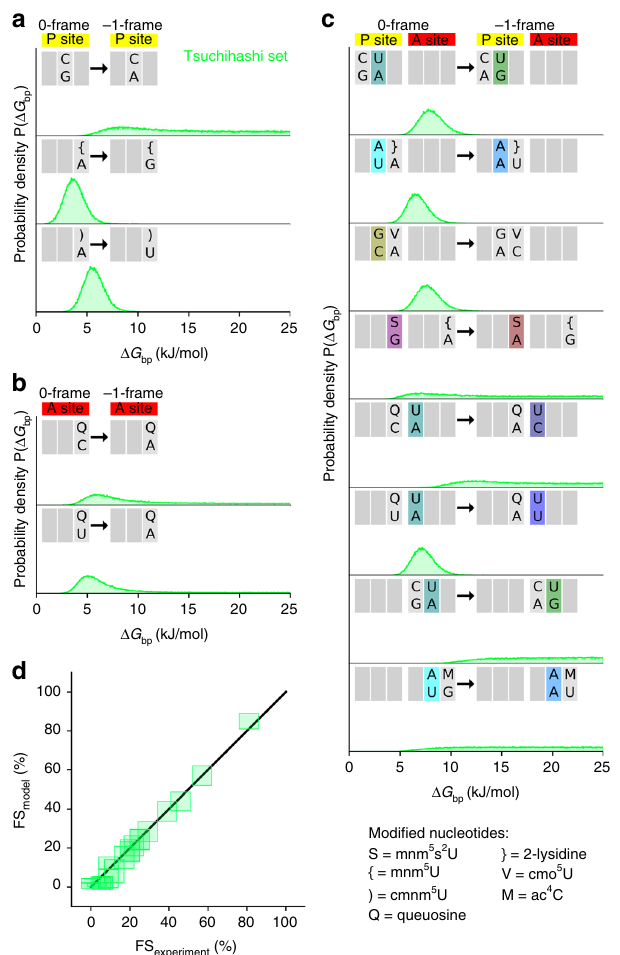
Fig. 4 mRNA – tRNA base-pair free-energy differences obtained from published FS values measured in vivo 26 . a – c Probability densities of the free-energy differences Δ G bp upon changing base pairs in the P site, the A site, as well as in the P and A sites simultaneously, obtained from the free-energy model applied to the Tsuchihashi FS set. d FS values from the Tsuchihashi set compared to those calculated from the model (rmsd 2.6%). For each mRNA sequence, one square is centered at the mean value and the width and height correspond to two times the standard